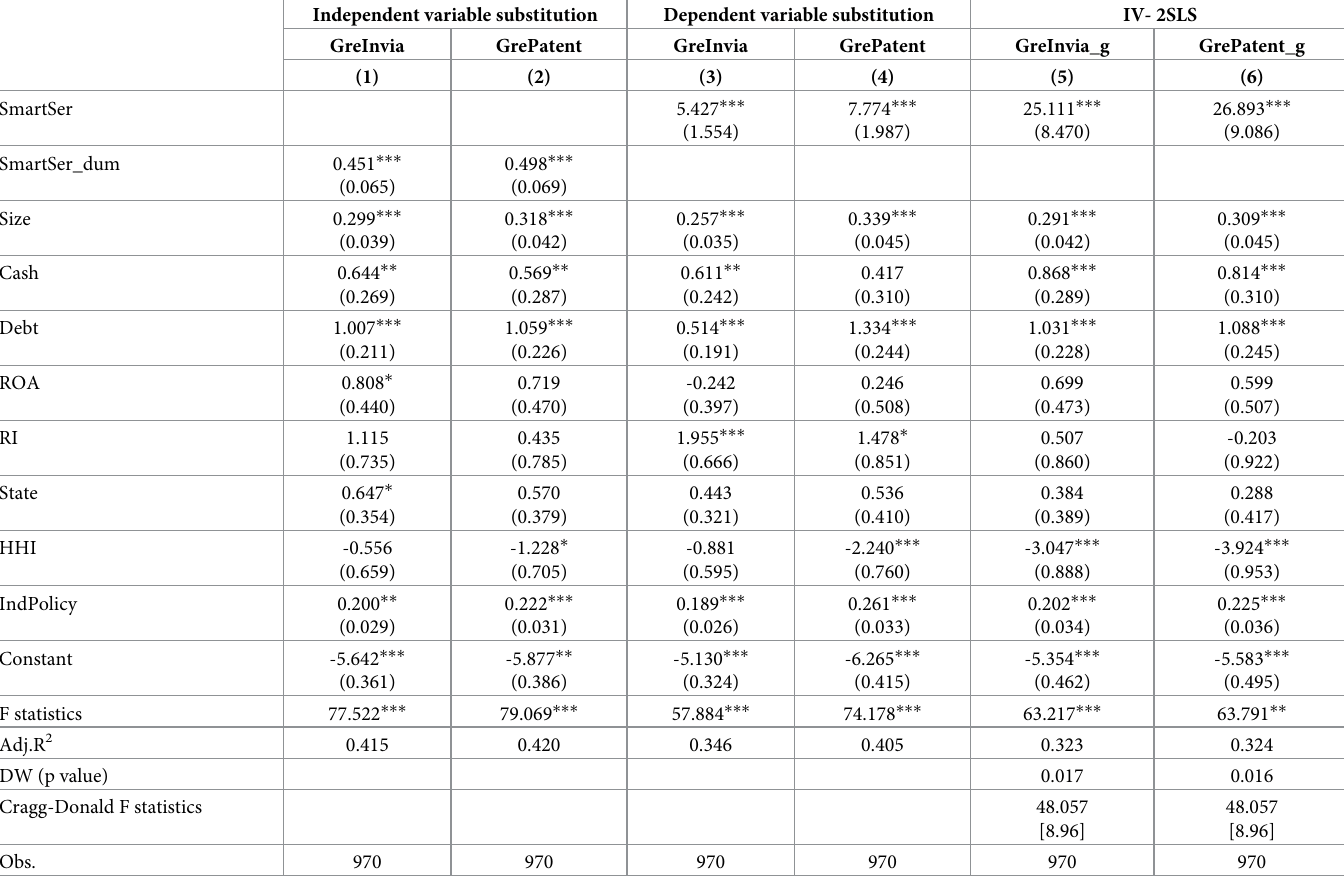
Table 12. Robustness